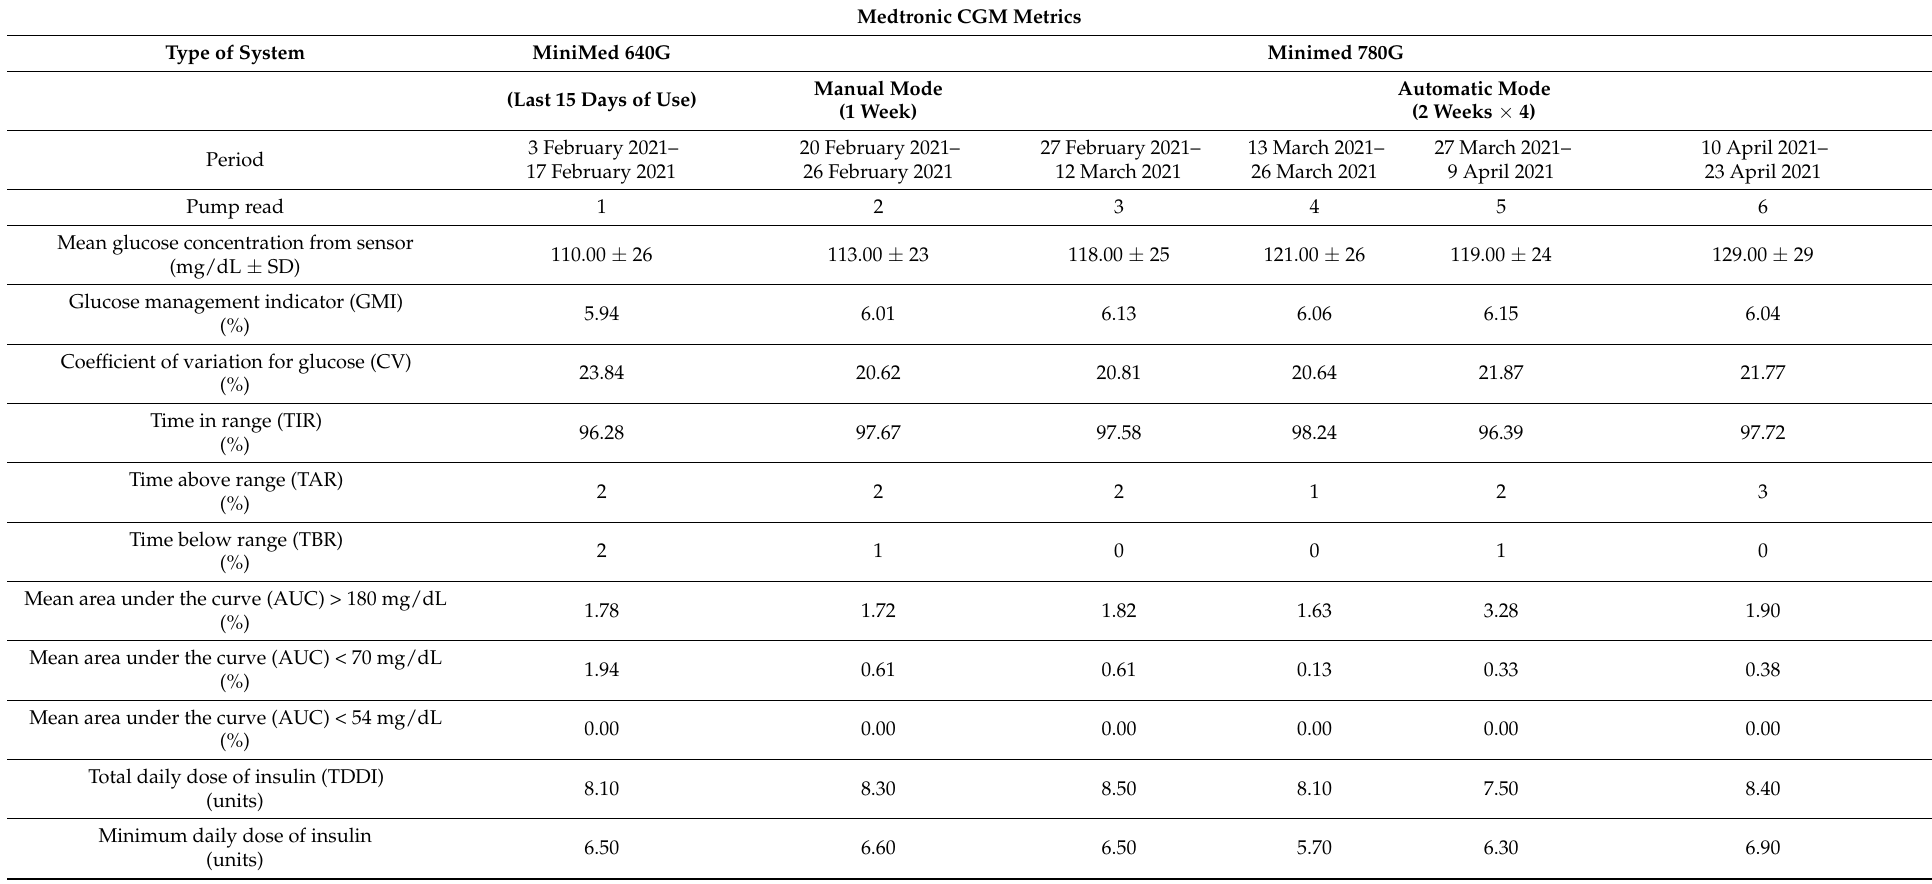
Table 2. CGM metrics during therapy with the Medtronic MiniMed780G